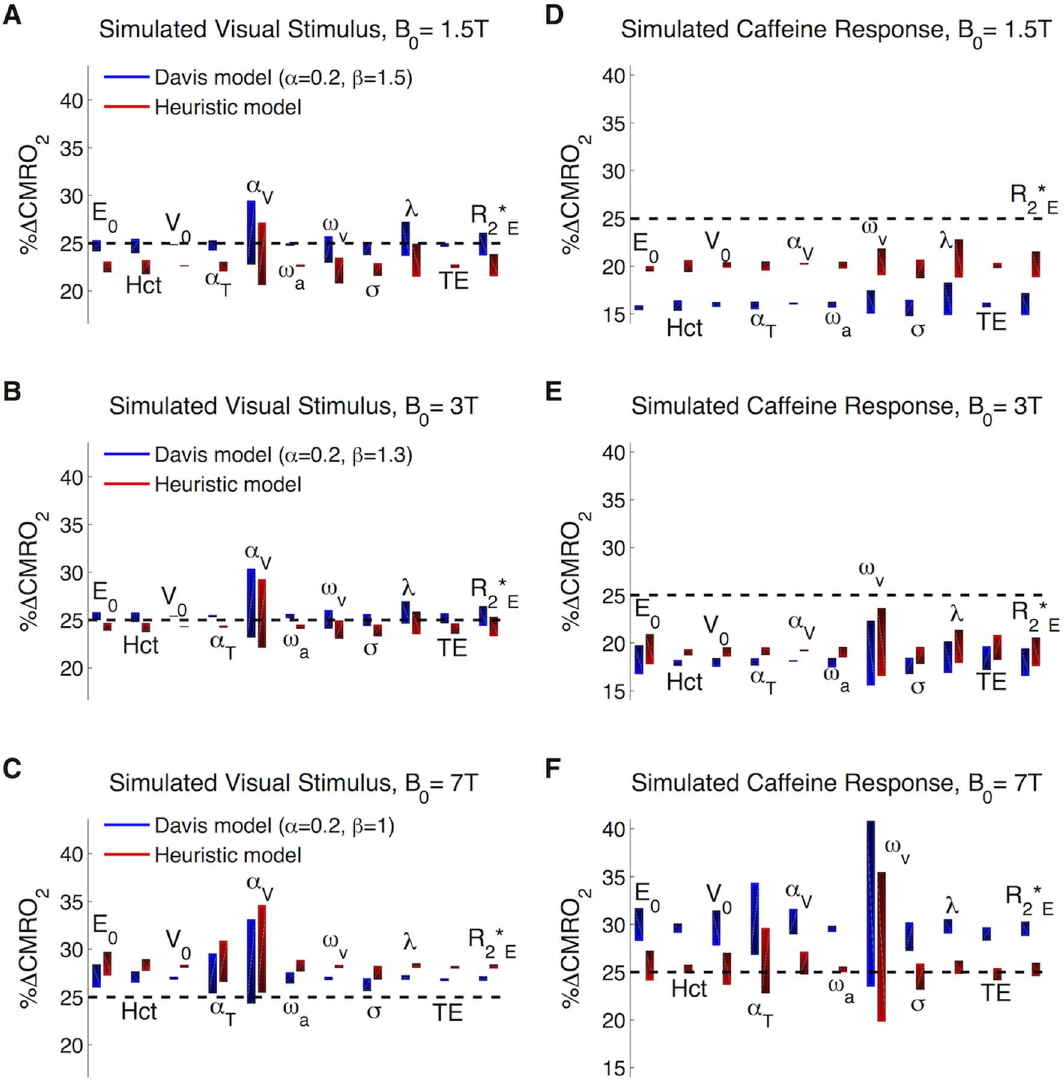
Figure 2. Heuristic vs. B 0 -adjusted Davis model applied to the calibrated BOLD experiment: Estimating % D CMRO 2 calculation bias due to variability in physiological parameters. Eleven input parameters to the detailed model were varied around reasonable values as defined in Tables 1 and 2 while other parameters were held constant at the best guess of physiology. The activation and ideal hypercapnia experiments were simulated for each of these physiological states at (A,B) 1.5T, (C,D) 3T and (E,F) 7T. The true CMRO 2 change with activation is shown as a dashed line, while the bars showing the range of calculated values is shaded from dark to light for increasing values of the associated physiological parameter. Davis model parameters a and b were adjusted for B 0 as noted in the figure. In the heuristic model, a v =0.2 across all B 0 . (A,C,E) Accuracy of the models at n =2 (% D CBF=50%) and variable B 0 . (B,D,F) Accuracy of the models at n = 2 1 (% D CBF= 2 25%) and variable B 0 . Note values for a and b in the Davis model are consistent for each B 0